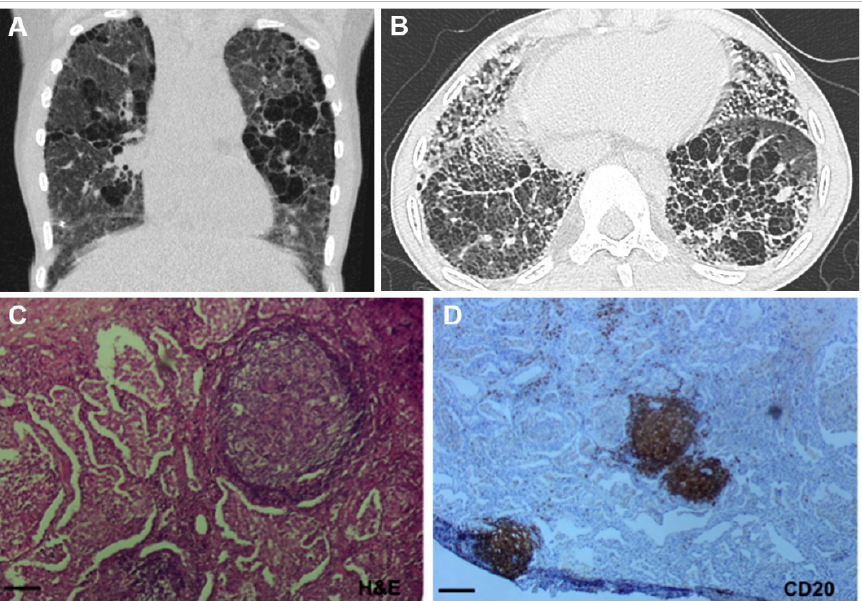
Figure 3. Representative Lung Imaging and Pathology in SAVI. ( A , B ) Coronal and axial image of a chest computed tomography (CT) scan from a SAVI patient showing interstitial lung disease with ground glass opacities, cysts, and septal wall thickening. ( C , D ) Lung tissue section biopsy from a SAVI patient showing lymphoid infiltrate consisting mainly of CD20+ cells. Original magnification: ×40 ( C ; scale bars, 100 µm), ×10 ( D ; scale bars, 400 µm) Adapted from Jeremiah et al., J Clin Invest, 2014 and Frémond et al., J Allergy Clin Immunol Pract, 2021.